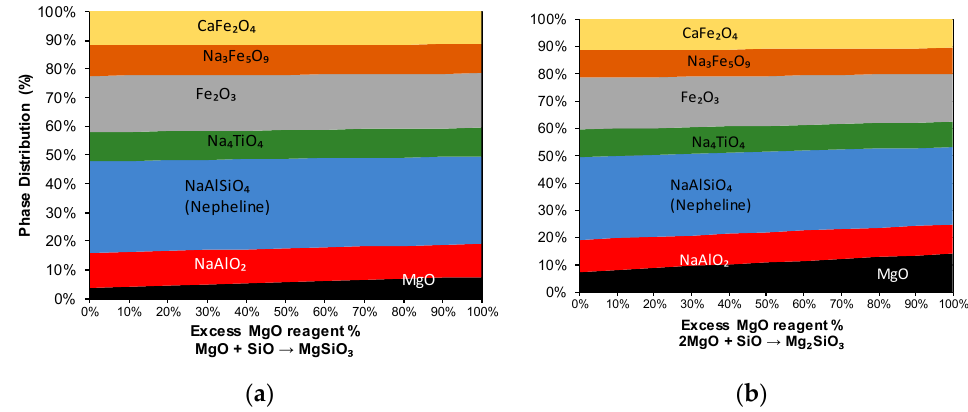
Figure 15. Thermodynamic predictions of sinter phase formation ( a ) when monomagnesium silicate is expected or ( b ) when dimagnesium silicate is expected at excess of MgO additions at 50% excess soda, 900 °C for 2 h.